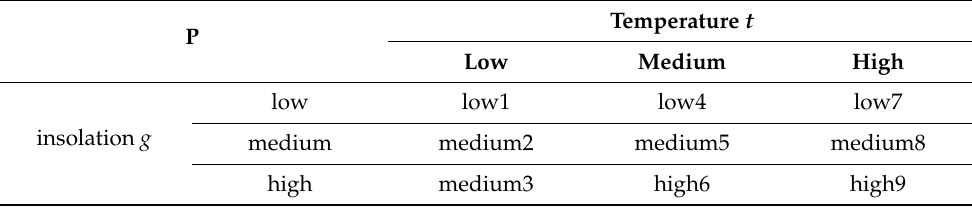
Table 3. Computed linguistic values of P based on the training data set.